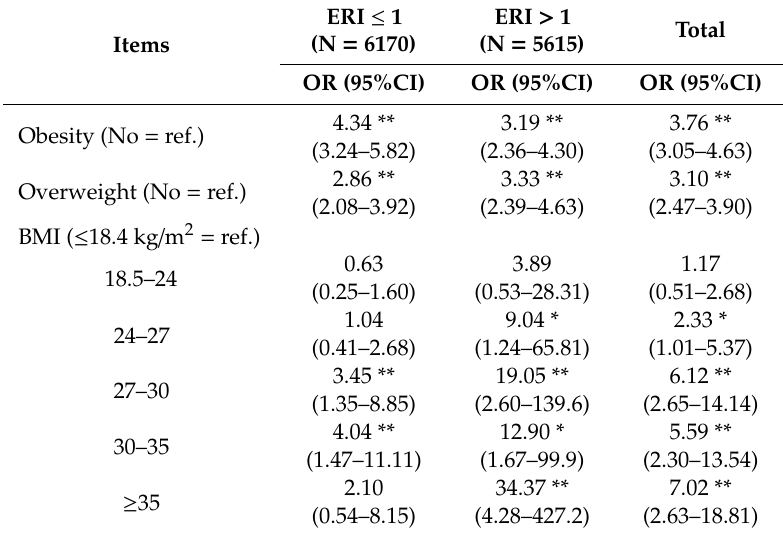
Table 6. Obesity / overweight associated with T2DM in two groups of ERI using multiple logistic regression adjusted for gender, age, smoking, alcohol consumption, and betel nut chewing.